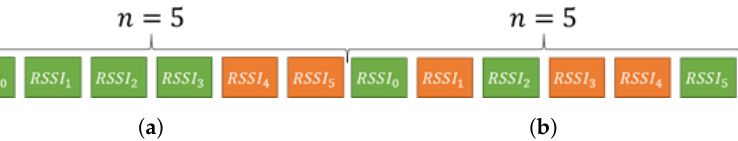
Figure 10. ( a ) Case where the adversary starts transmitting right after the legitimate node terminated its transmission; ( b ) The adversary gains access to the channel while the legitimate node has not finished transmitting all of its